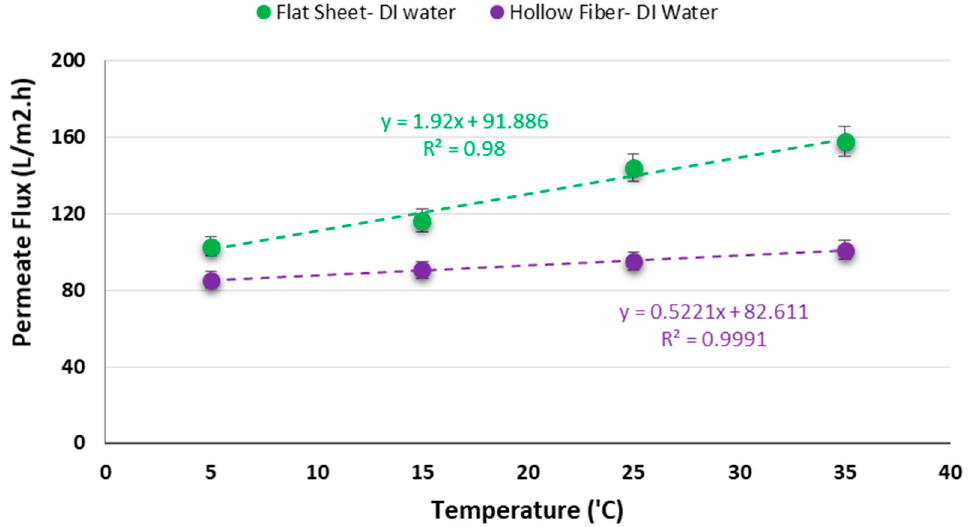
Figure 5. Impact of temperature on permeate flux for two different membrane modules.